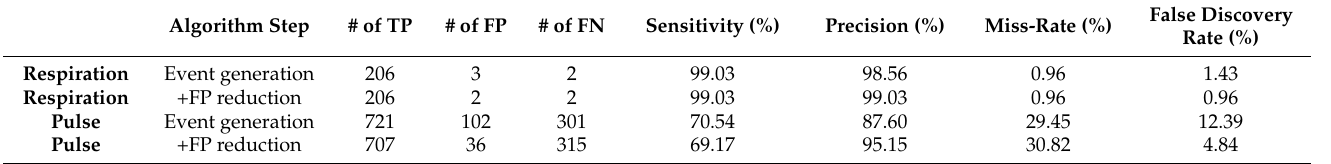
Table 3. Respiratory and cardiac event detection performance after event generation and false positive